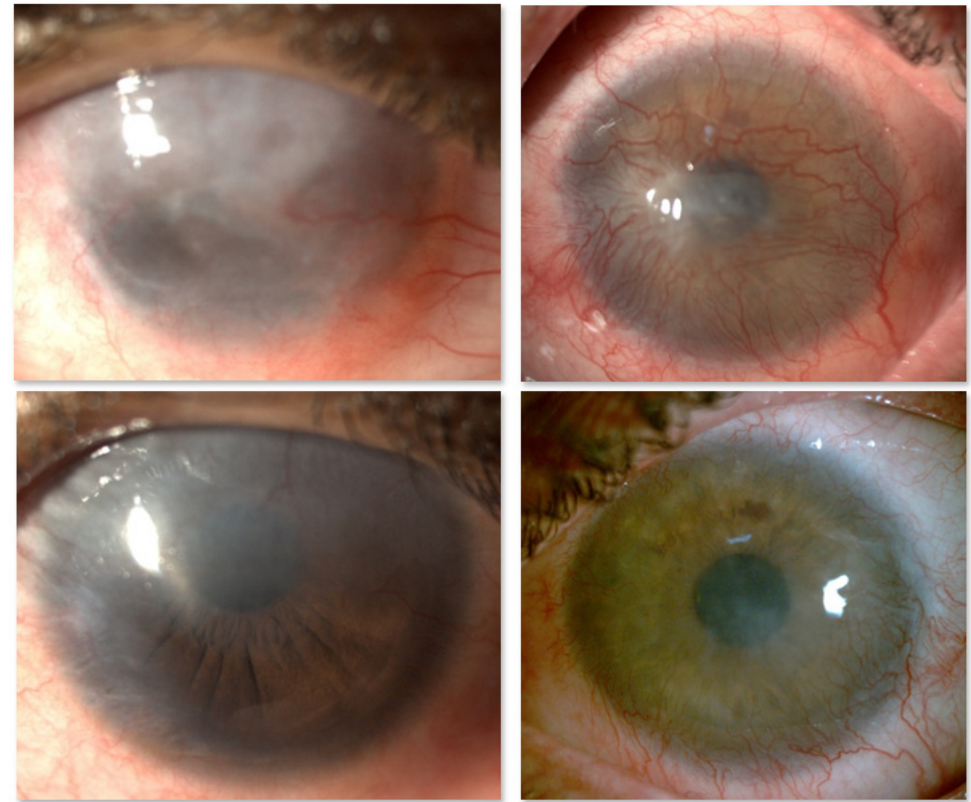
Figure 3. Chemical injury in two different patients, before ( upper panel ) and 12 months after ( lower panel ) successful cultivated limbal epithelial transplantation (CLET). The source of the limbal epithelial cultivated stem cells was autologous, from the fellow healthy eye ( left panel ) or allogeneic from cadaveric limbal ring ( right panel ).